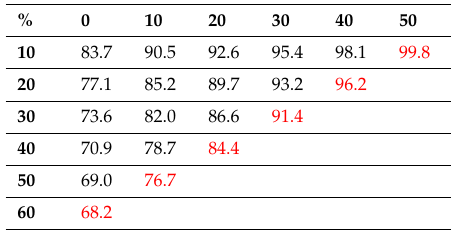
Table 11. Classification accuracy over the number of subjects classified by the model and number of subjects removed from the classification